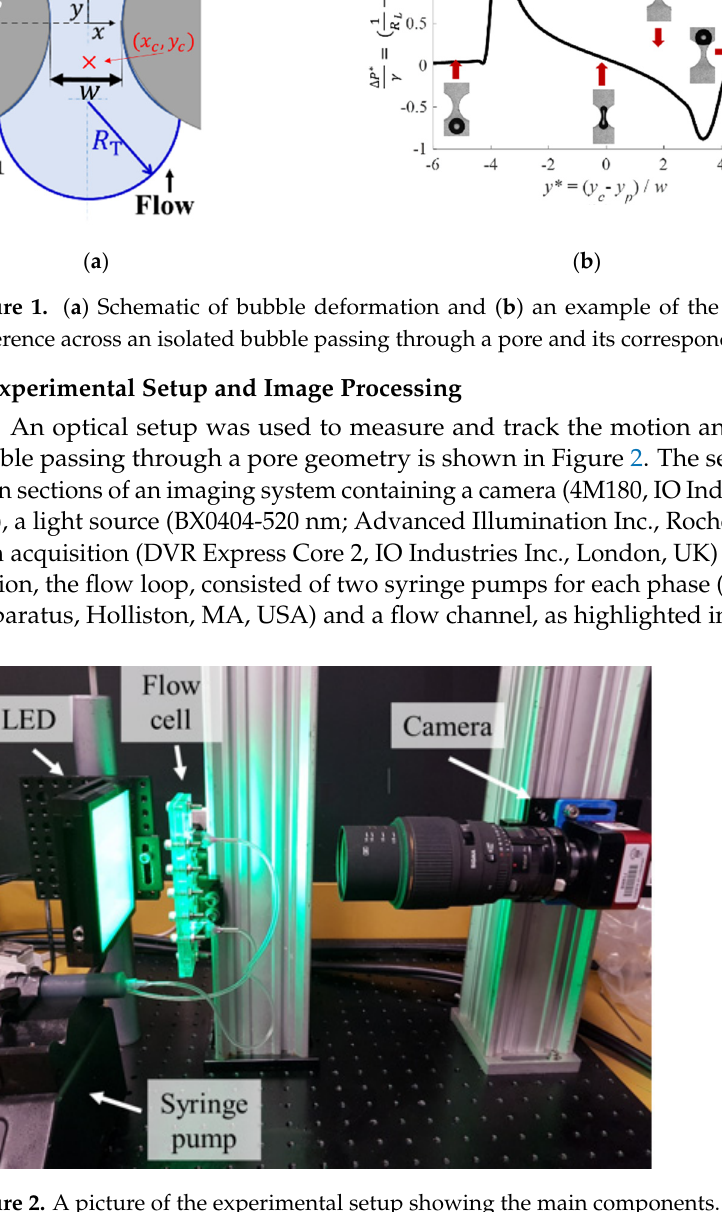
Figure 2. A picture of the experimental setup showing the main components.